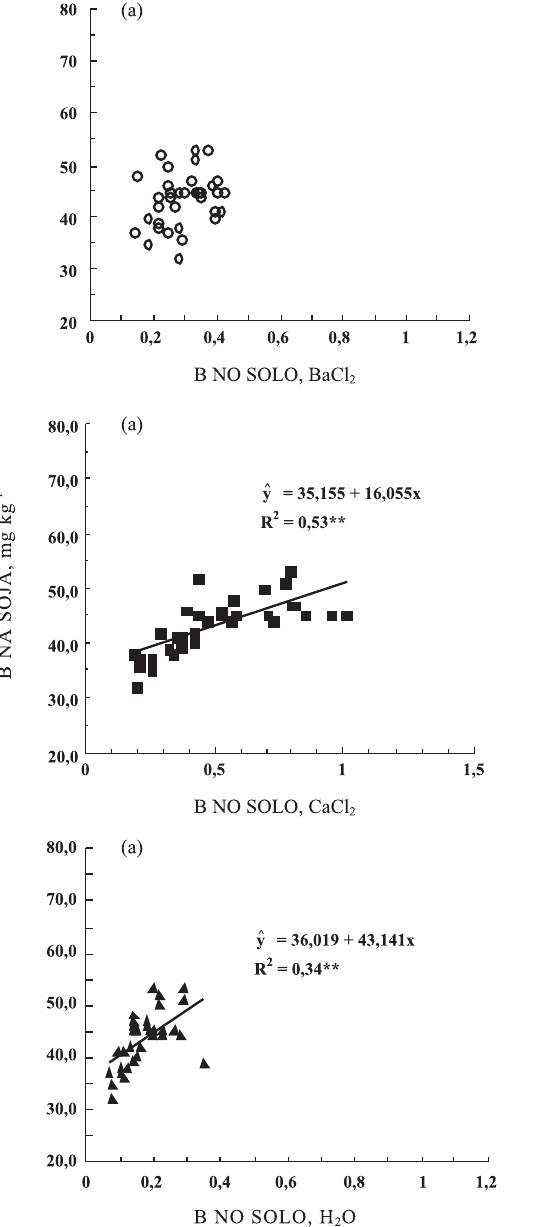
Figura 4. Teor de boro em folhas de soja em função de teores de B no solo, determinados com